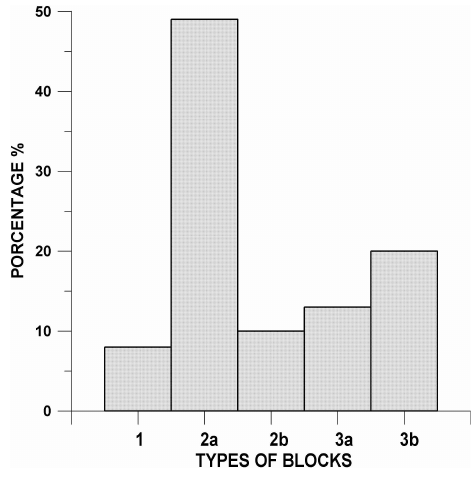
Fig. 8. Distribution of the different types of residential blocks in